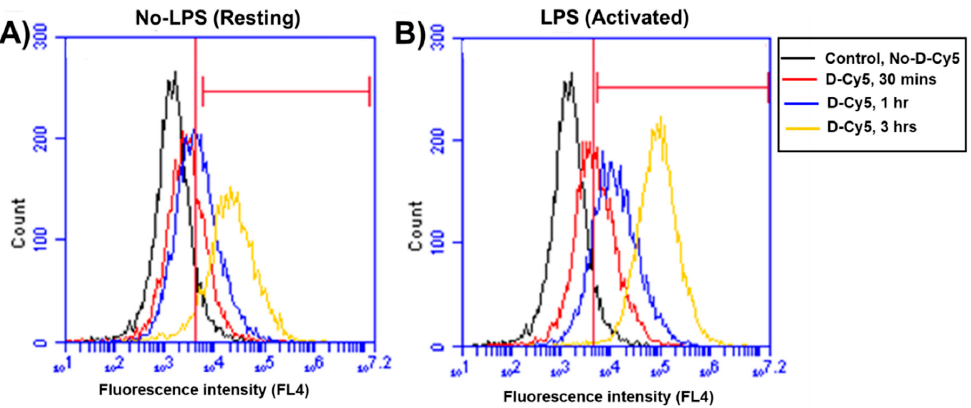
Figure 3. Flow cytometry analysis of time-dependent differential uptake of dendrimer (D-Cy5) by lectin stained microglia/macrophages population in mixed glial culture. ( A , B ) Histograms of lectin +Ve cells (Microglia/macrophages) showing minimal D-Cy5 uptake (Red) at 30 min in both resting and activated conditions compared to controls (Black). Shift in histograms of lectin +Ve cells (Microglia/macrophages) show increased dendrimer uptake at 3 h. A larger percentage of the activated microglia/macrophage population (~85%) shows D-Cy5 uptake, whereas only ~60% of cells show D-Cy5 uptake in the group without LPS treatment.